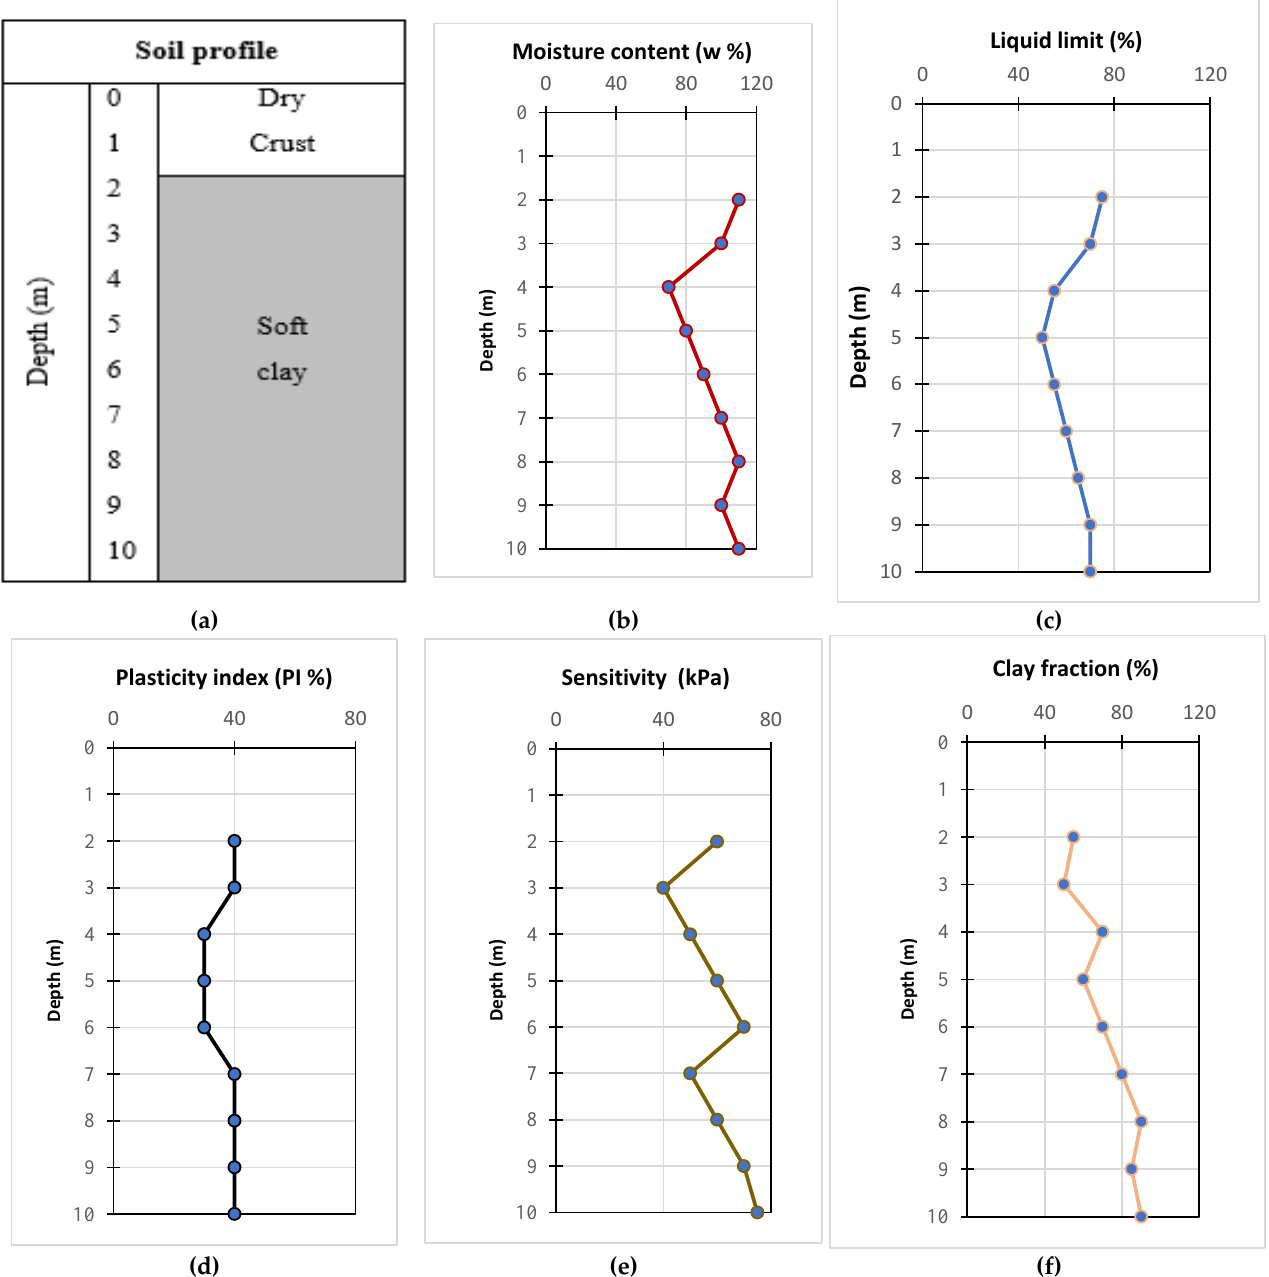
Figure 2. Variation of geotechnical properties; ( a ) soil profile with depth ( m ); ( b ) moisture content w ( % ) with depth ( m ) ; ( c ) liquid limit ( % ) with depth ( m ); ( d ) plasticity index ( % ) with depth ( m ); ( e ) sensitivity ( kPa ) with depth ( m ); ( f ) clay fraction ( % ) with depth ( m ) [46].